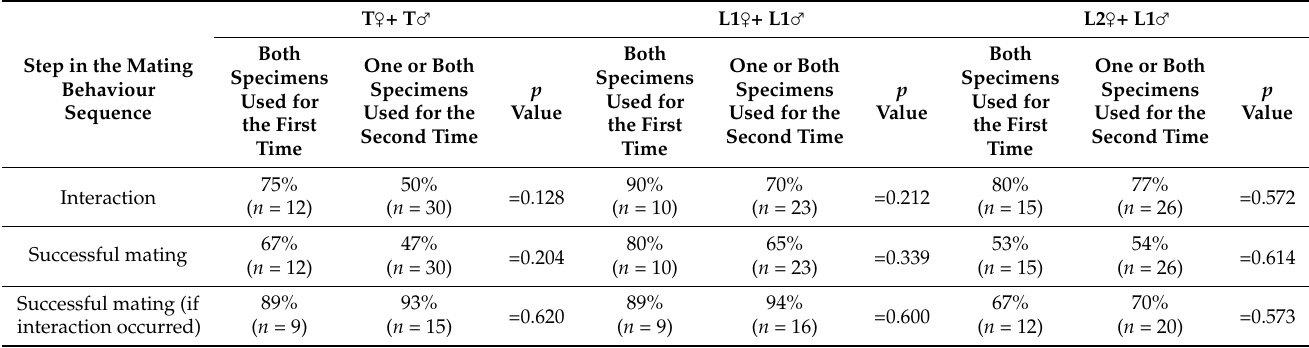
Table 3. The percentage of pairs that completed each step in the mating behaviour sequence for T-T, L1-L1 or L2-L1 Thrips tabaci pairs together with the significance level of their